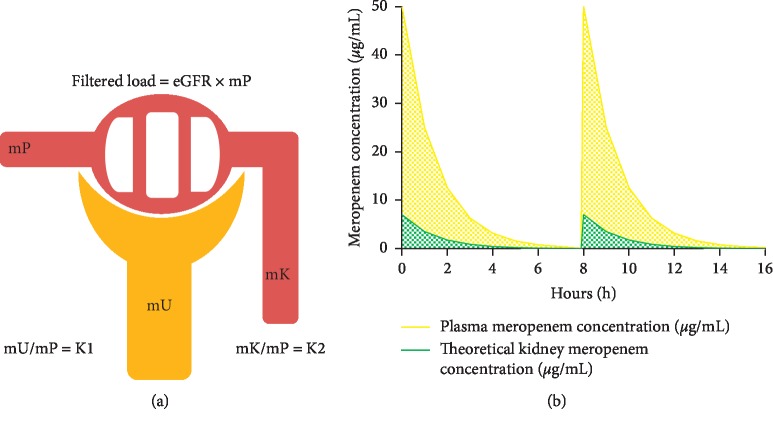
Theoretical mK/mP ratio and concentration decay curves. As long as the eGFR remains constant, the filtered load will depend on “mP” over time. The higher the plasma concentration, the higher the filtrate, determining first-order elimination. Thus, the relation mU/mP will be equivalent to a constant (K1) over time. This determines that the remaining concentration in the kidney will also be maintained at a constant rate over time (mK/mP = K2). With this in mind, and assuming that the ratio mK/mP is 0.14, we can graph the decay curve and thus estimate the doses necessary to achieve the MIC-90 in the renal parenchyma. mK: kidney meropenem concentration; mP: plasma meropenem concentration; mU: urine meropenem concentration.